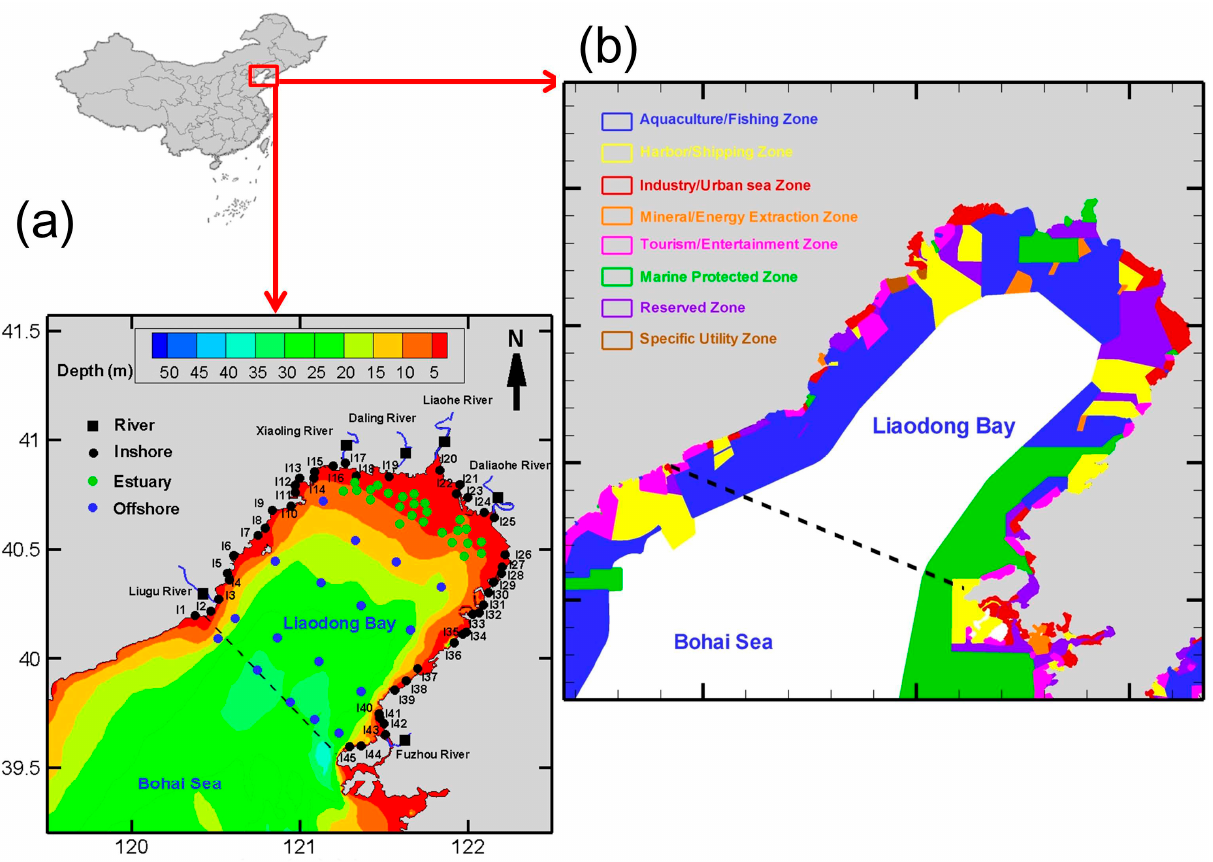
Figure 1. Sampling stations ( a ) and marine spatial planning areas ( b ) in the Liaodong Bay.